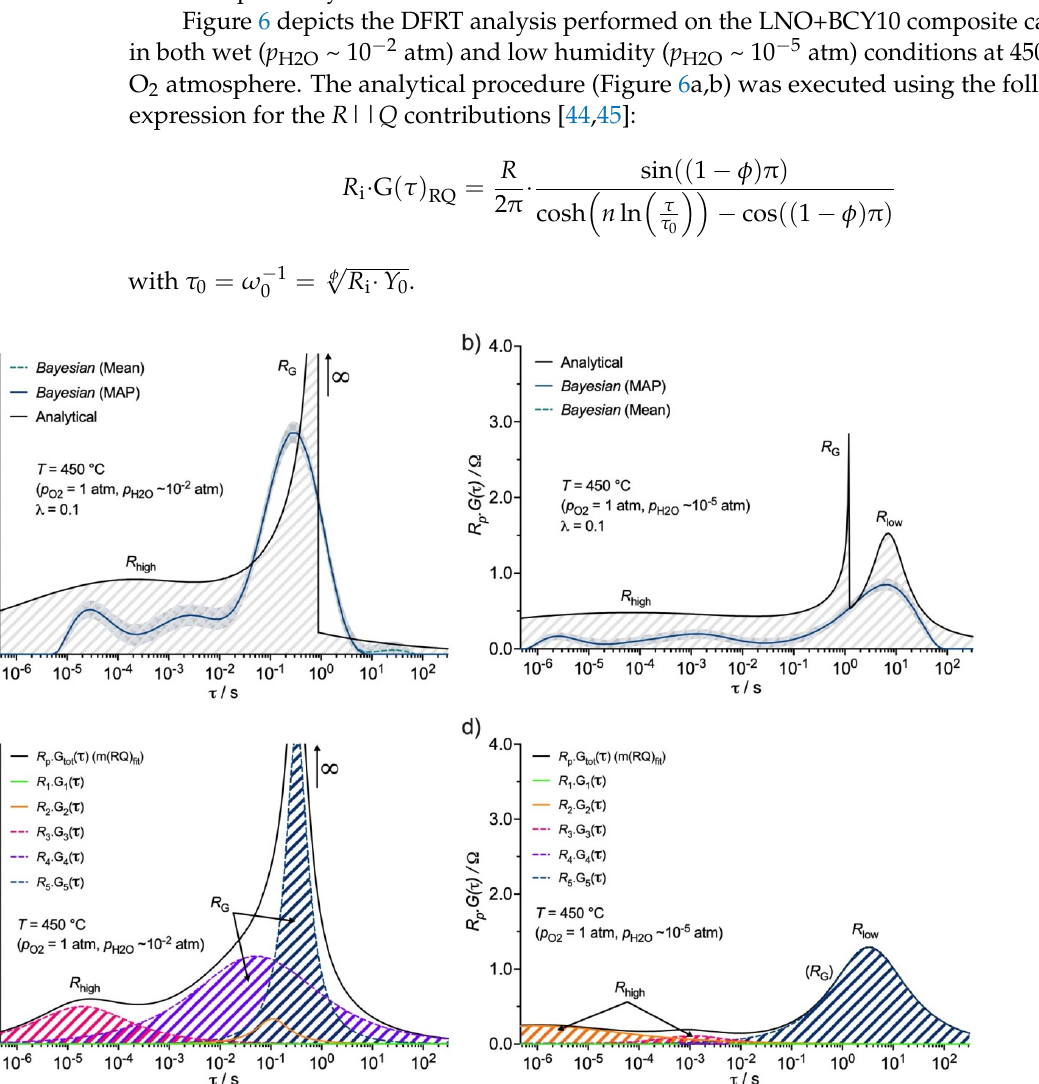
Figure 6. Distribution function of relaxation times (DFRTs) obtained from an EQM of a linear combination of ( R || Q ) and ( G ) elements and using the Bayesian regularisation of the EIS data obtained in ( a ) wet ( p H2O ~ 10 − 2 atm) and ( b ) low humidity ( p H2O ~ 10 − 5 atm) conditions at 450 °C in O 2 atmosphere (the 99% credibility interval is presented in the shadow area around the Bayesian curves). An alternative approach to obtain a DFRT based on an EQM with a linear series of ( R || Q )-circuits, designated as multi-fit procedure ( m (RQ) fit ), is depicted in ( c , d ) for, respectively, wet and low humidity atmospheres.